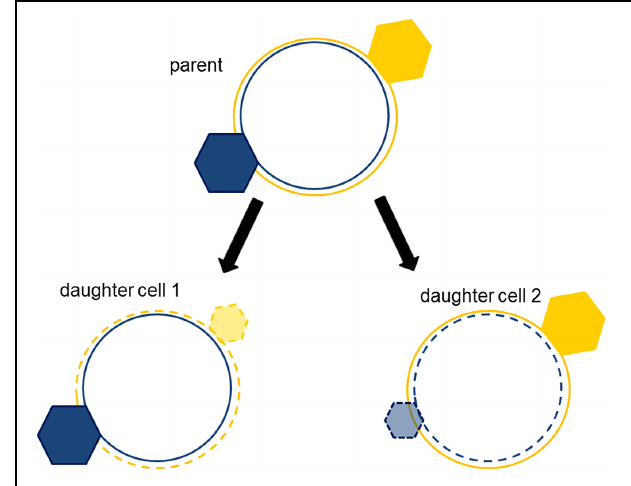
FIGURE 3 | Strand segregation of hyperstructures creates complementary, coherent phenotypes. The hyperstructure (hexagon) associated with an old strand (continuous circle) is segregated with the old strand into the daughter cell. New hyperstructures (translucent hexagons) associated with the new strands (dotted circles) are smaller because they must compete with the parent cell’s hyperstructures (solid hexagons).